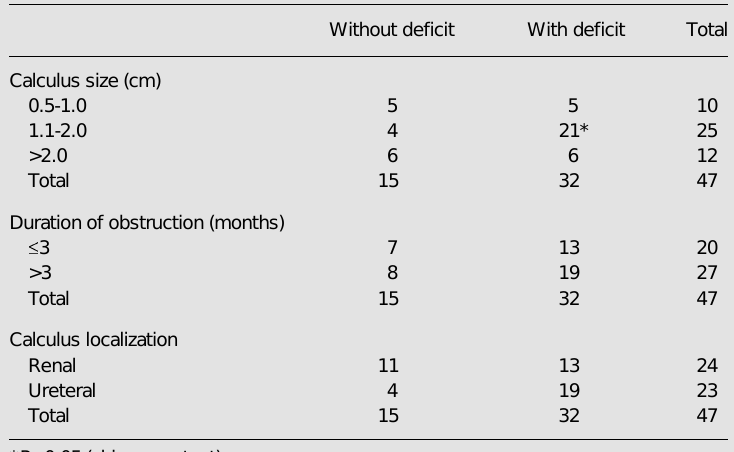
Table 1. Association between unilateral functional deficit and calculus size, duration of obstruction and calculus localization by 99m Tc-diethylene triamine pentaacetic acid (DTPA) scintigraphy.